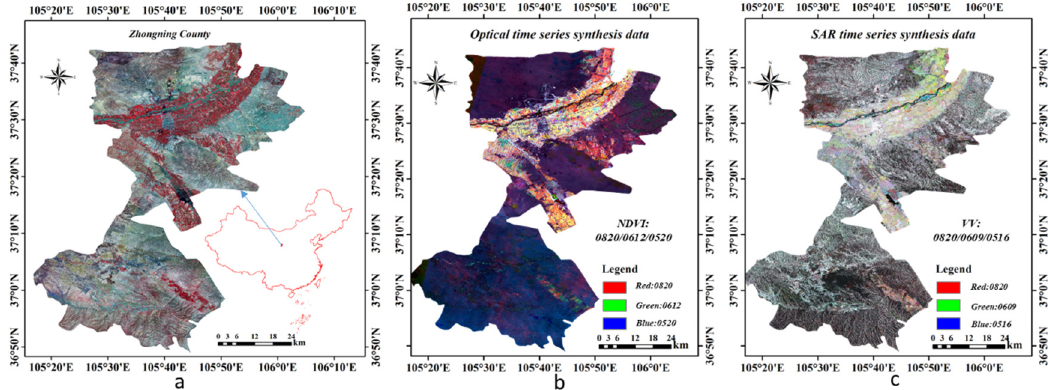
Figure 6. Study area: ( a ) Zhongning County; ( b ) false color image based on multitemporal NDVI data; and ( c ) false color image based on multitemporal VV polarization data.